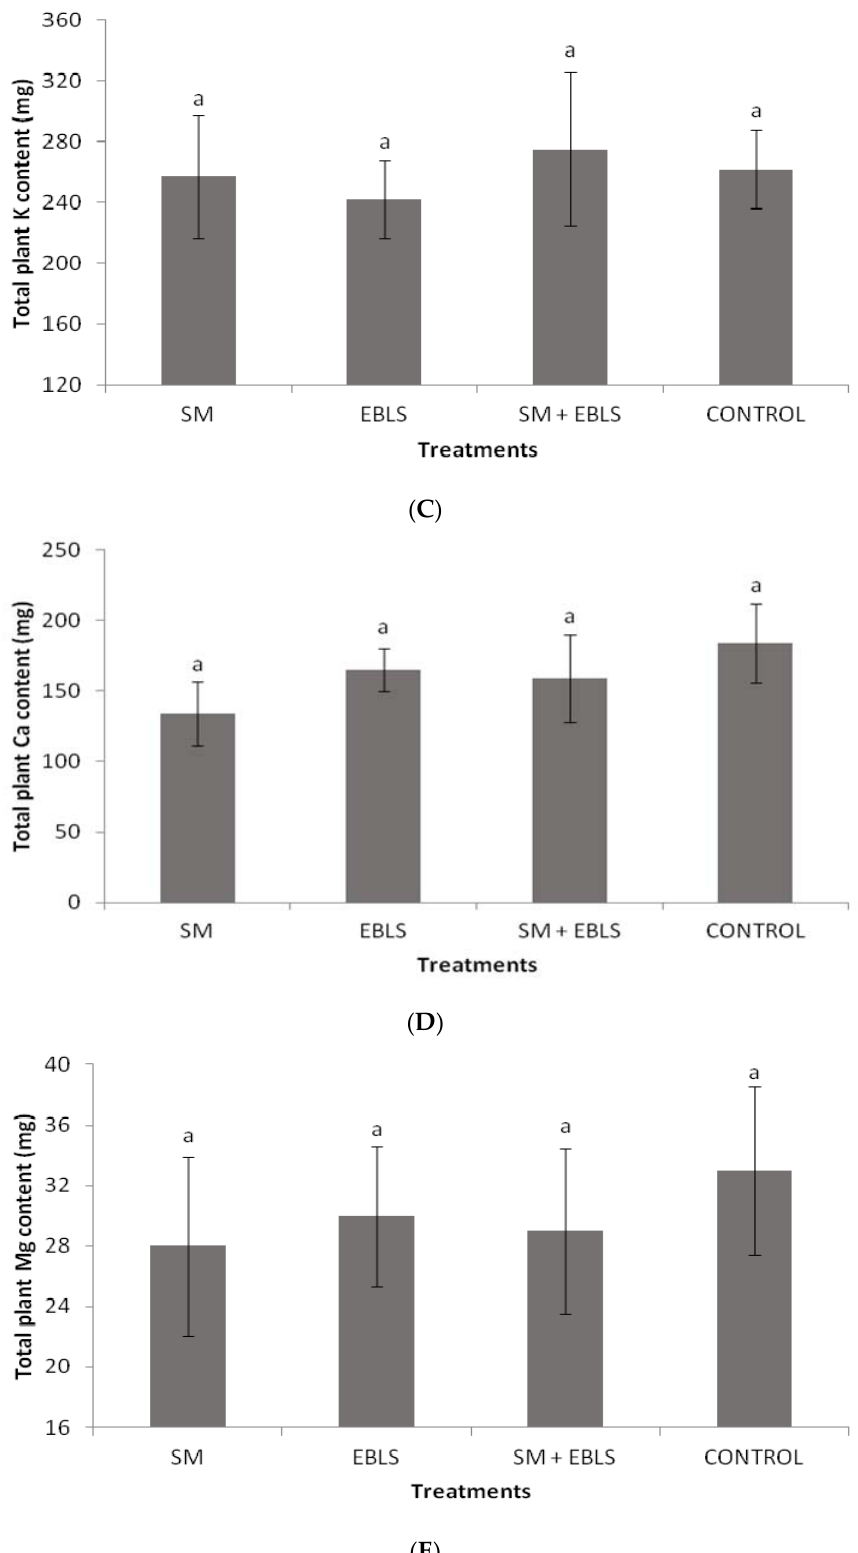
Figure 1. Total plant N ( A ), P ( B ), K ( C ), Ca ( D ), and Mg ( E ) content among the treatments. The different letters on the bars symbolize statistically significant differences among the treatments, according to Duncan’s multiple range test for p ≤ 0.05. SM = sheep manure; EBLS = organic material (litter) from evergreen broadleaf species, i.e., from Quercus sp.